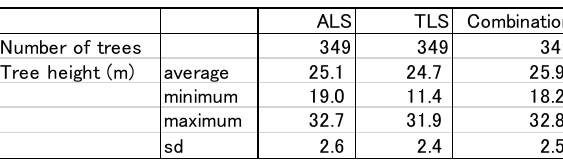
Table 4. Comparison of tree height measurements obtained by ALS, TLS, and the combination method ALS Sample trees Number of trees average tree height (m) Table 5. Comparison of average tree height, measured by ALS, with sample trees Individual level : Table 6 and Figure 4 show a comparison of individual-level tree height measurements obtained by TLS and by the combination method, using ALS data as a reference. The tree height RMSEs for data obtained by TLS and the combination method were 1.7 and 1.2, respectively, showing that tree height estimation by the combination method was better than that by TLS alone. Figure 5. Sliced point clouds representing detected and non- detected